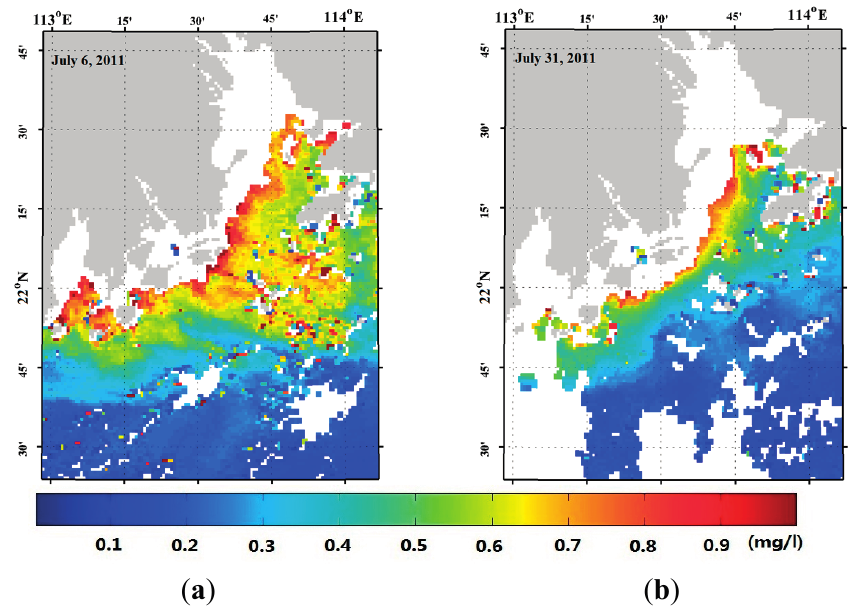
Figure 11. Satellite-derived POC concentrations in summer with different discharge from the Pearl River on ( a ) 6 July 2011; ( b ) 31 July 2011. Valid POC concentrations in the white regions were not obtained due to cloud cover, contamination by sun-glint, band saturation of MODIS,